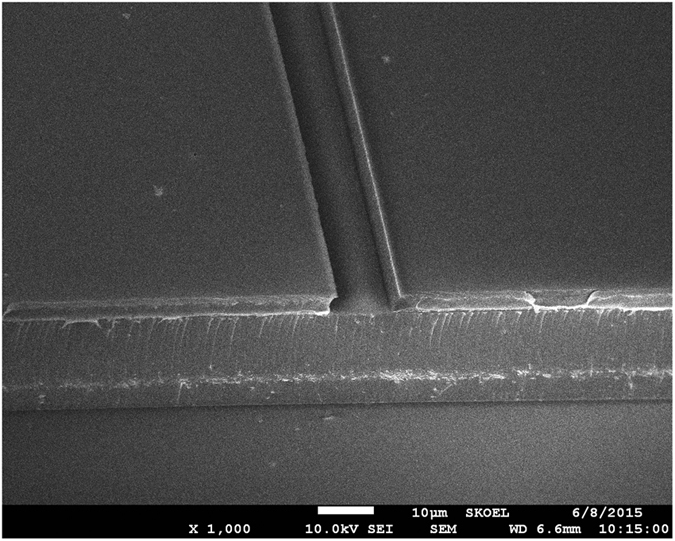
The SEM micrograph of the groove cross-section without embedding the NaYF4/NaLuF4: Yb3+, Er3+ NPs-PMMA.